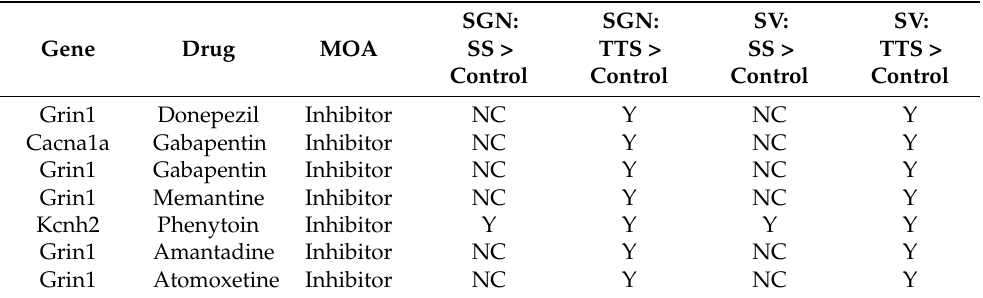
Table 3. FDA approved, orally administered CNS drugs that interact with steroid-responsive genes in the cochlea localized to SGN and SV cell types.